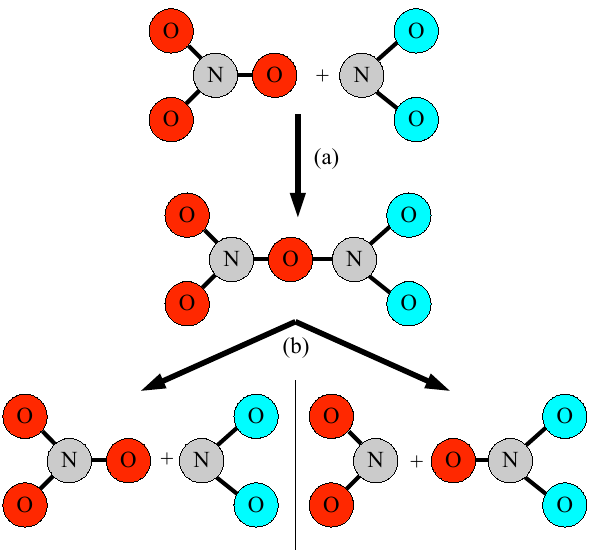
Fig. 2. Schematic illustrating the fate of oxygen atoms from NO 3 (in red) and NO 2 (in blue) during the formation (a) and decompo- sition (b) of N 2 O 5 . Owing to the symmetry of the N 2 O 5 molecule, the N − O bonds are expected to have an equal probability to break upon thermal decomposition or photolysis. The 1 17 O of NO 2 formed upon this dissociation corresponds to the average between the 1 17 O of NO 2 and NO 3 making up N 2 O 5 . The 1 17 O of NO 3 formed upon the dissociation of N 2 O 5 is a slightly more complex function, due to the fact that in half cases two out of the three oxy- gen atoms of NO 3 initially stem from NO 2 , while one comes from the original NO 3 . See Sect. 3.2.2 for